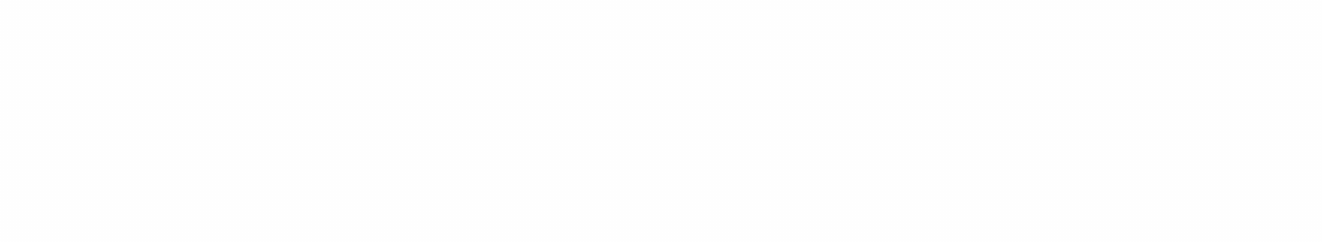
FIGURE 4 A swallow tail singularity P+ with a selection of contours of the state surface for varied values of/3 displaying the creation of a cusp doublet (dashed